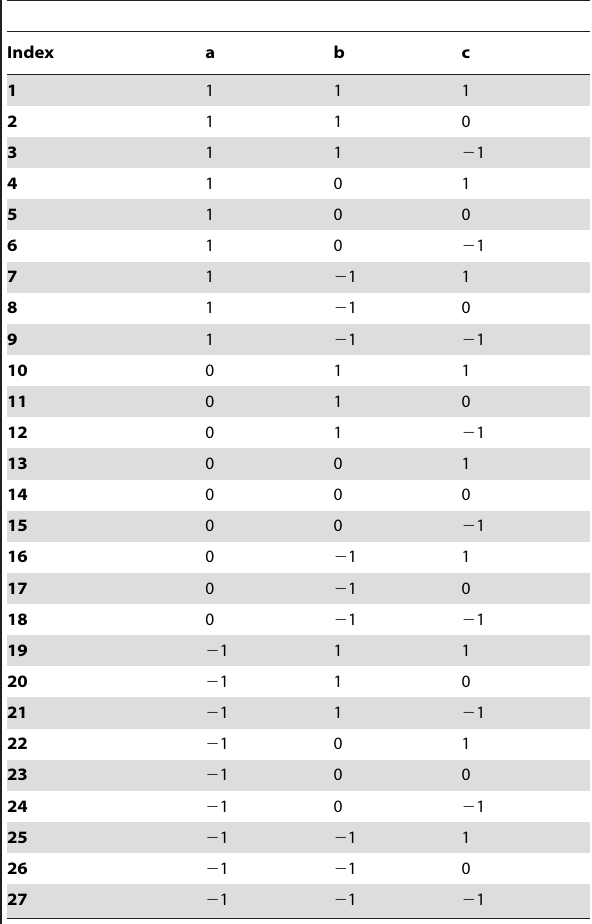
Table 1. All possible sets of interactions for links a, b, c in Fig.